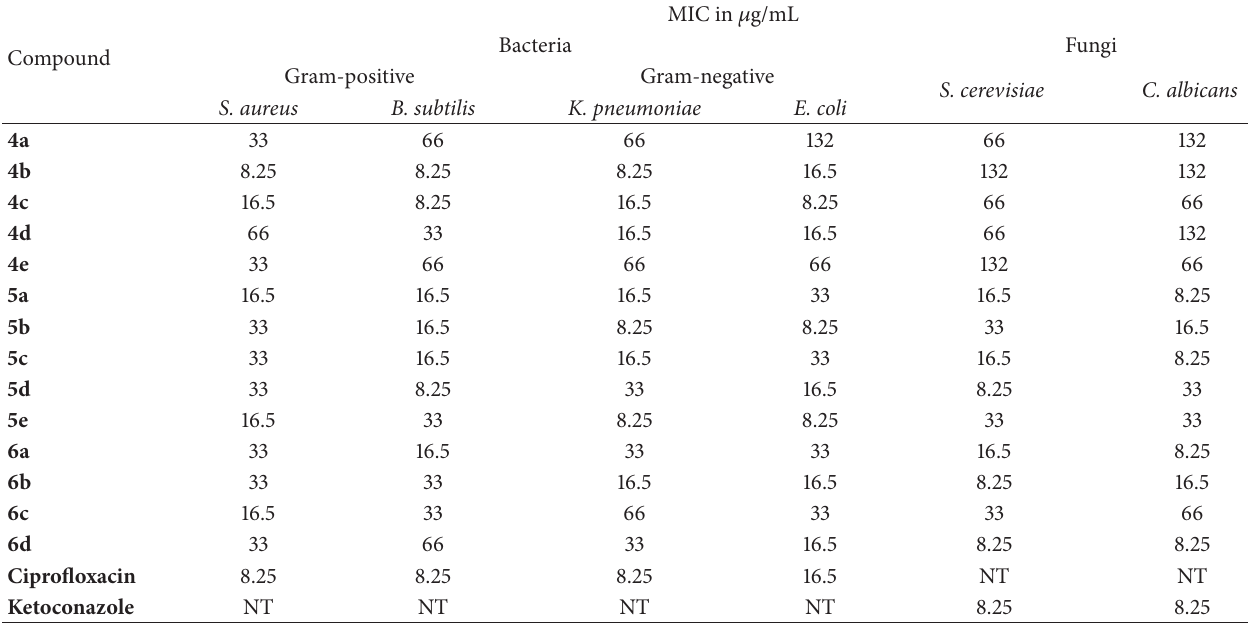
Table 2: Minimum inhibitory concentration ( 𝜇 g/mL) against the pathological strains based on twofold serial dilution technique.